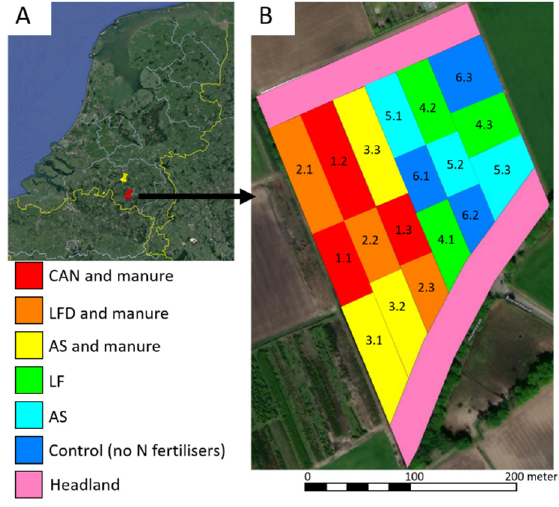
Figure 2. The location where the bio-based fertilisers were produced (Oirschot, yellow dot), and the location where the field experiment took place (Eersel, red dot) ( A ), together with the location of the different replenished treatments in the field (three repetitions) ( B ).